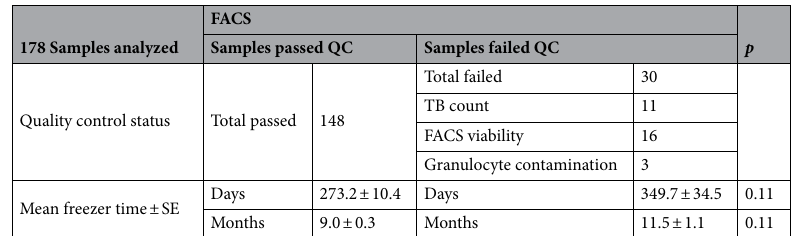
Figure 1. Quality control data. ( A ) Frequency distribution of Trypan Blue counts in thawed samples. The percent frequency of post-thaw sample PBMC counts measured using the Trypan Blue exclusion test. Samples containing more than 500,000 cells, indicated by the dotted line, proceeded to quality control phase two. ( B ) Frequency distribution of alive CD45+ Cells in thawed samples. The percent frequency of CD45+ cells that were negative for the Zombie Red viability stain as a percent of CD45+ cells in the sample. Samples with a survival rate of 70%, indicated by the dotted line, were considered viable for future use.